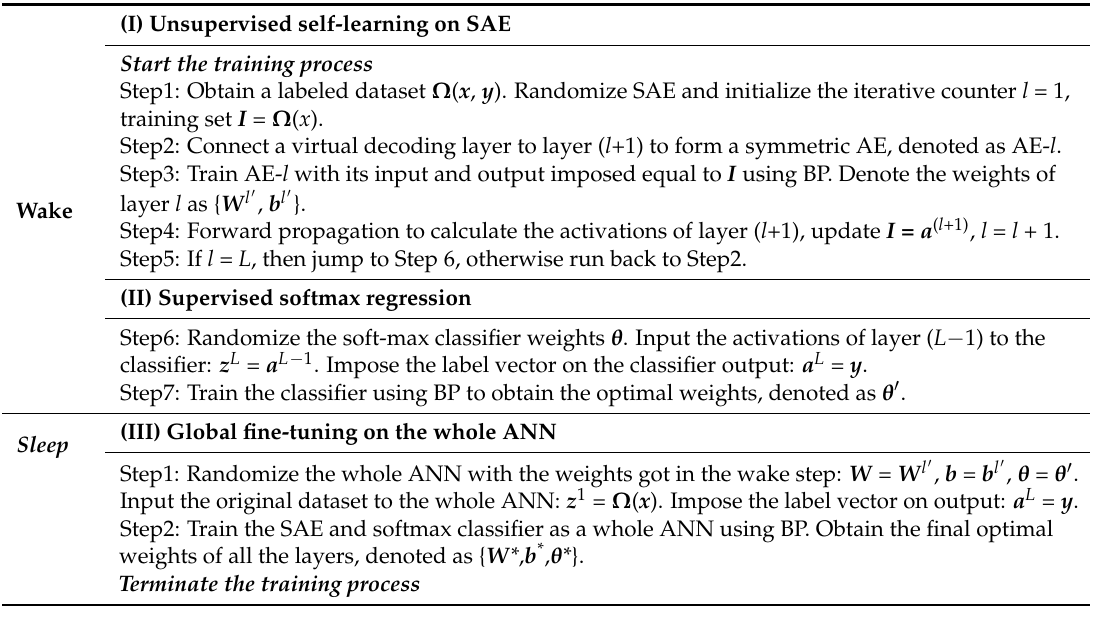
Table 1. Procedure of the greedy layer-wise training and